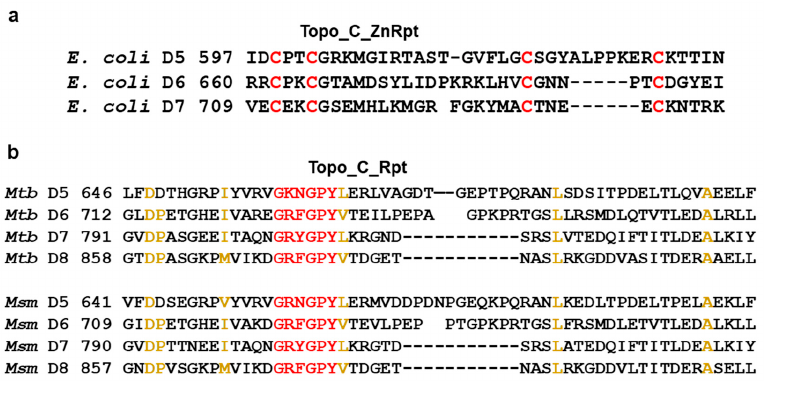
Figure 1. Prototype sequences for bacterial topoisomerase I C-terminal domains. ( a ) Topo_C_ZnRpt in EcTOP1. Cysteines for Zn 2+ coordination are colored in red. ( b ) Topo_C_Rpt in MtbTOP1 and MsmTOP1. Residues that are part of the signature sequence are colored in red. Other highly conserved residues are colored in gold. Table 1. Number of species with Topo_C_ZnRpt or Topo_C_Rpt in individual bacterial phylum. Phyla with the greatest number of species listed in the Pfam database as having PF01396 (Topo_C_ZnRpt) or PF13368 (Topo_C_Rpt) are shown